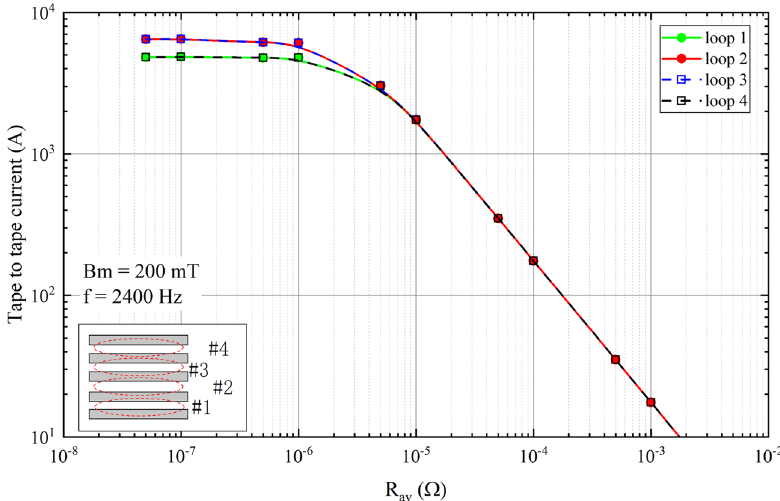
Figure 6. The tape-to-tape current amplitude when the stack is suffering from 200 mT cross-field. The resistance is increased from 5 × 10 − bottom to top in the sketch as 1 to